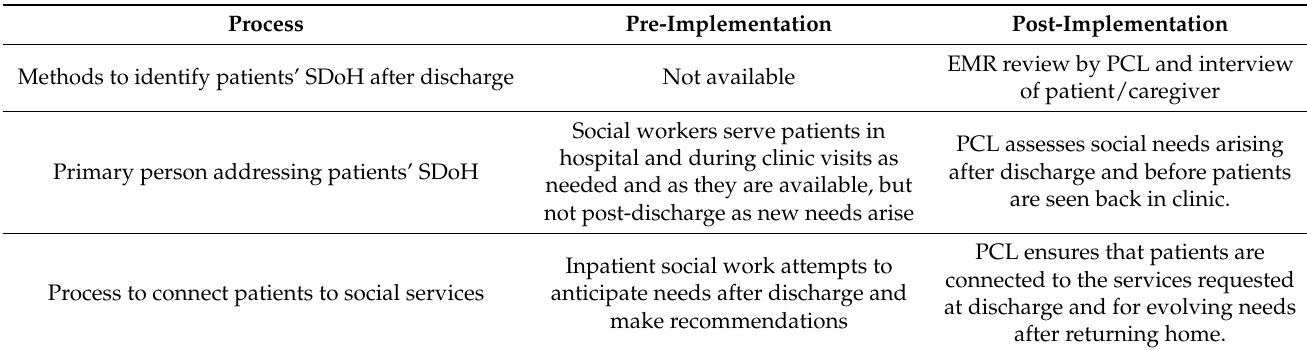
Table 5. Changes in referral process before and after